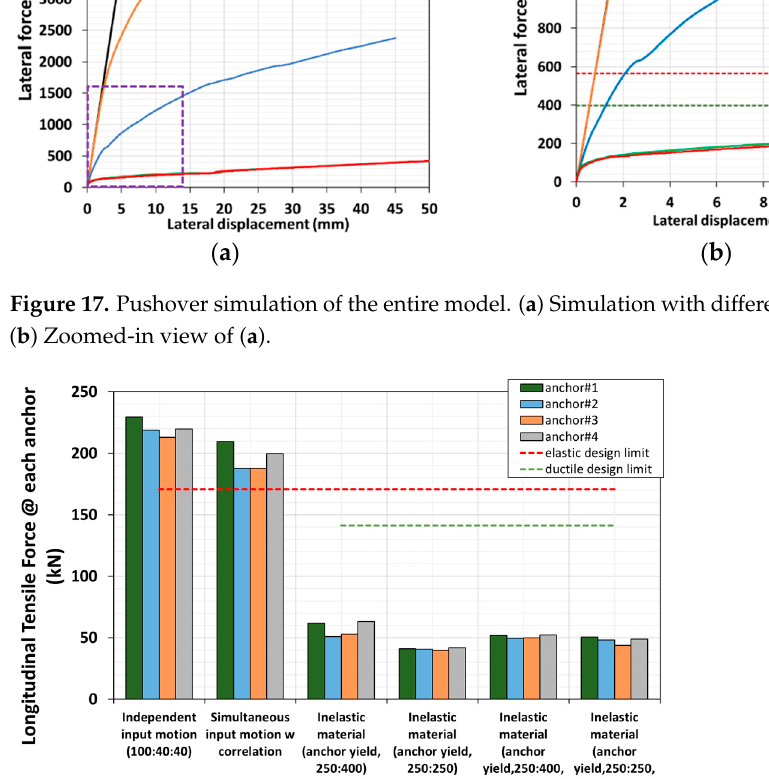
Figure 17. Pushover simulation of the entire model. ( a ) Simulation with different failure mecha- nisms. ( b ) Zoomed-in view of ( a ).